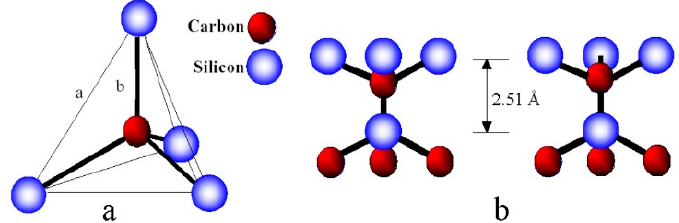
Figure 9. ( a ) Basic unit cell of silicon carbide. The distance between Si-Si or C-C atoms, a, is about 3.08 Å , and between C-Si atoms, b, is approximately 1.89 Å . ( b ) The two configurations of silicon and